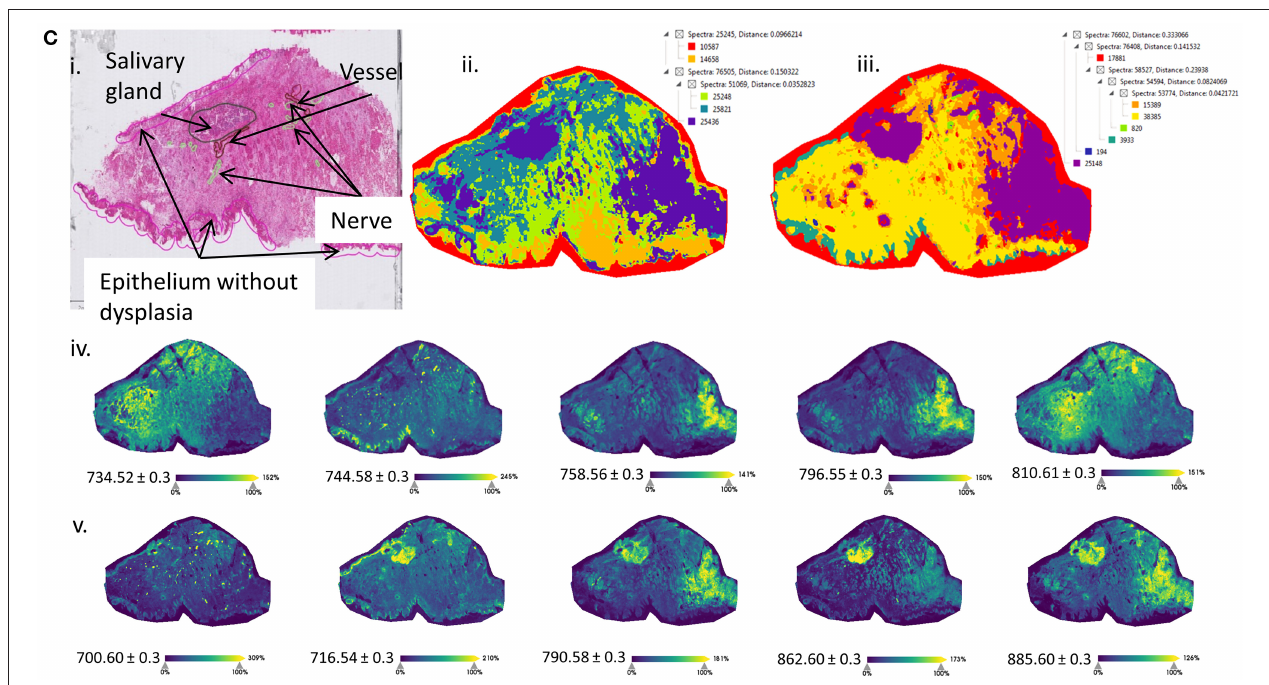
FIGURE 3 | Optical images and MS imaging data of the prospective cohort. Matrix-assisted laser desorption ionization at 50 µ m spatial resolutions was used to measure sections in both the positive and negative ion modes. All the data were subjected to the bisecting K-means segmentation. Each part of the figure presents the: (i) detailed histopathological annotations, (ii) image segmentation and cluster tree in positive ion mode, (iii) image segmentation and the cluster tree in negative ion mode, (iv) selected ion images in positive ion mode m/z ± 0.3 and (v) selected ion images in negative ion mode m/z ± 0.3 for (A) patient A, (B) patient C and